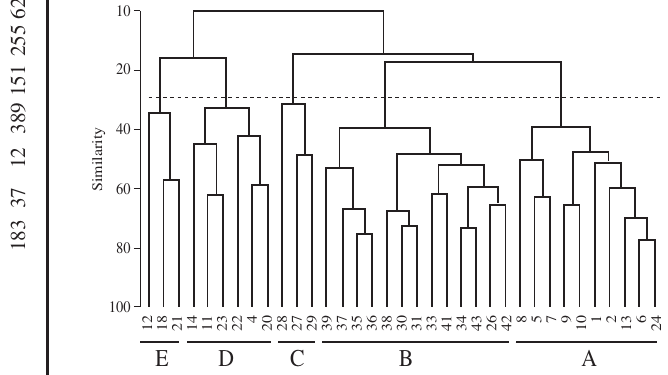
Fig. 2. – Hierarchical cluster analysis (square root-transformed abundances, bray-Curtis similarity coefficient) of the 35 sampling